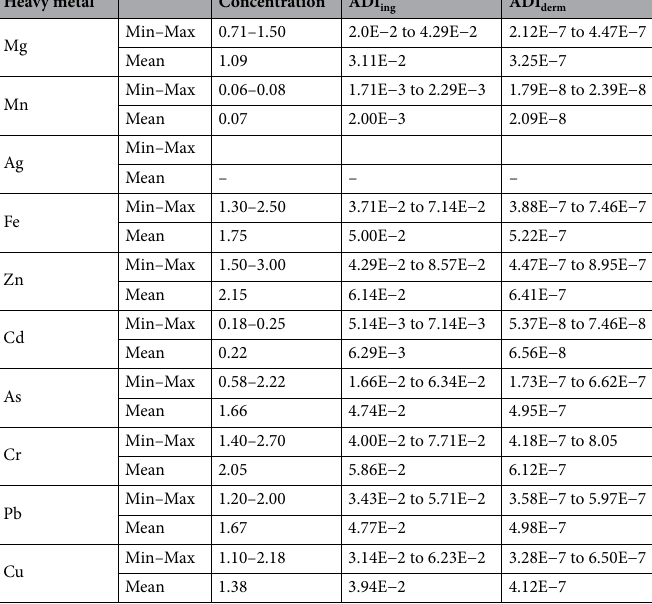
Table 13. Estimated annual dose intake of heavy metals in water samples collected within the study